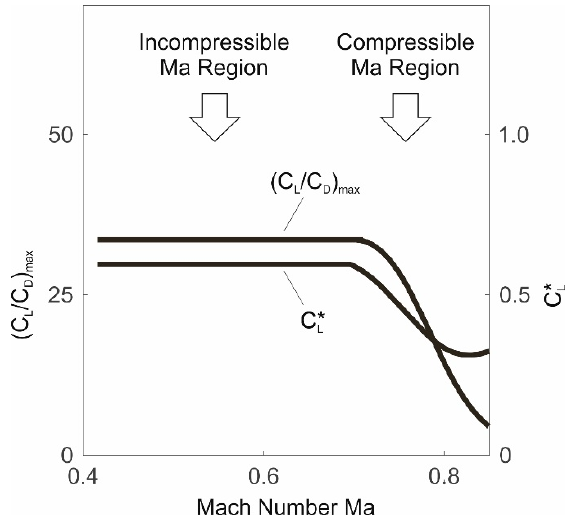
Figure 5. Maximum lift-to-drag ratio, (𝐶 (cid:3013) /𝐶 (cid:3005) ) (cid:3040)(cid:3028)(cid:3051) and associated lift coefficient, 𝐶 (cid:3013)∗ , dependent on Mach number, 𝑀𝑎 , (relating to drag polar in Figure 4 . Mach number, Ma , (relating to drag polar in Figure